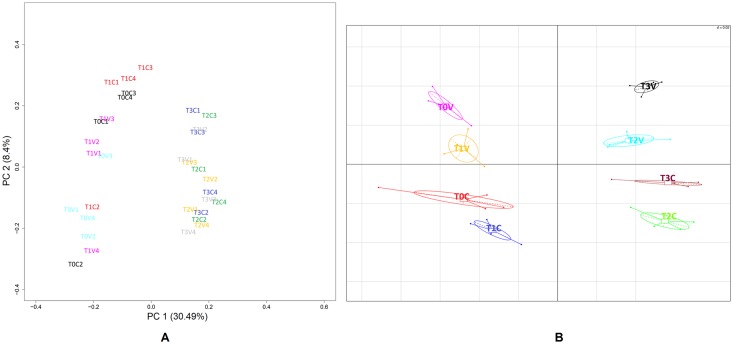
PCA and BGA analysis.(A) Principal component analysis (PCA). The 32 samples are projected onto the 2D plane such that they spread out in the two directions that explain most of the differences. The x-axis, so called the first principal component (PC1), is the direction that separates the samples the most. The y-axis, so called the second principal component (PC2), is an unrelated direction (it must be orthogonal to the first direction) that separates the data the second most. The percentage value in the axis label refers to the percent of the total variance that is contained in the direction. Each sample is represented as time points (T0-T3) followed by its animal ID. For example, T3V3 represents the transcriptome sample from vaccinated lamb V3 at time point 3 (14 wpi). (B) The between groups analysis (BGA) plot based on overall gene expression profiles of different groups in response to F. hepatica infection over the period of time. V and C represent vaccinated and control group respectively and their time point (0–3) is separated by a dot in each group.